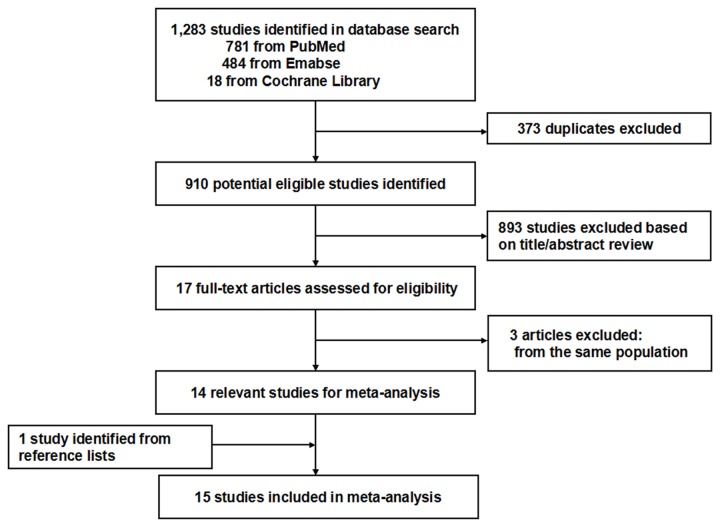
Flow diagram of screened, excluded, and analyzed publications.